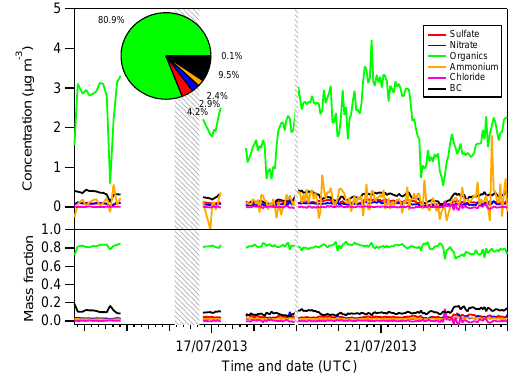
Figure 6. Submicron nonrefractory aerosol composition from the ACSM measurements along with equivalent black carbon from the MAAP measurements: concentration (top panel) and mass fraction (bottom panel). The pie chart shows the average proportions over the measurements. Shaded areas represent pollution episodes re- moved from the data. Any other gaps are due to instrument down-